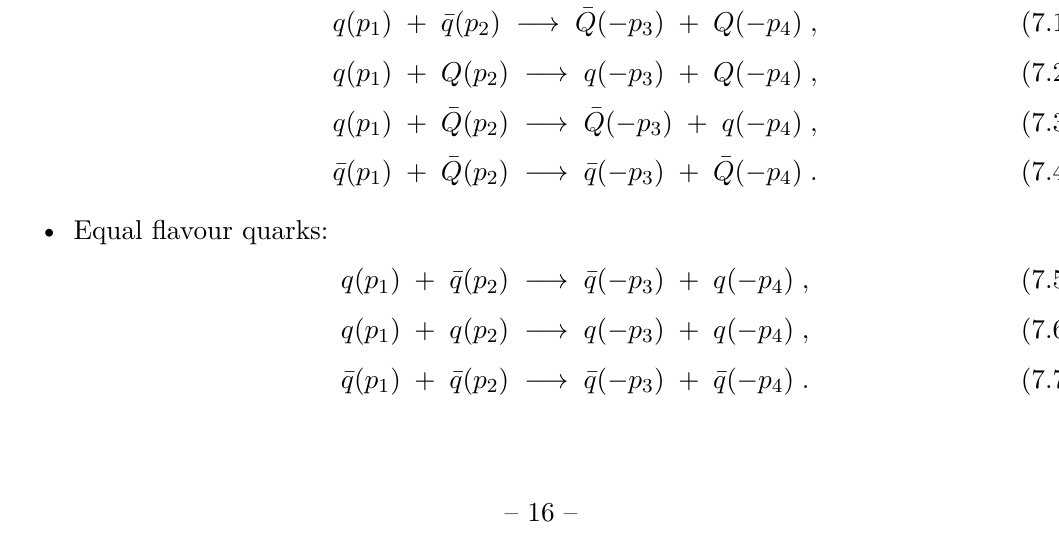
. Lastly, the index ( L ) refers to the number of loops of δ i 1 i 2 i 3 i 4